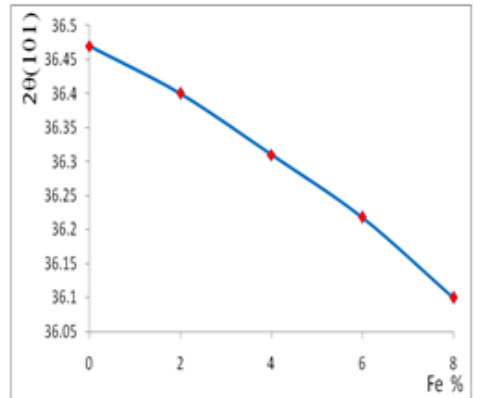
Fig.5 : The variation of 2θ (101) for ZnO thin film with Fe doping